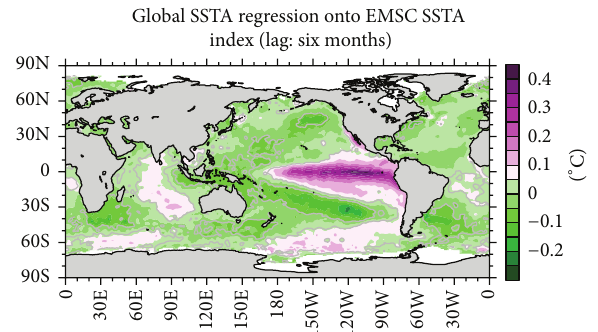
Figure 7: Global SSTA during 1982–2011 regression onto a lag of six months of standardized EMSC SST interannual index. The gray contours denote 95% confidence level using Student’s 𝑡 -test.